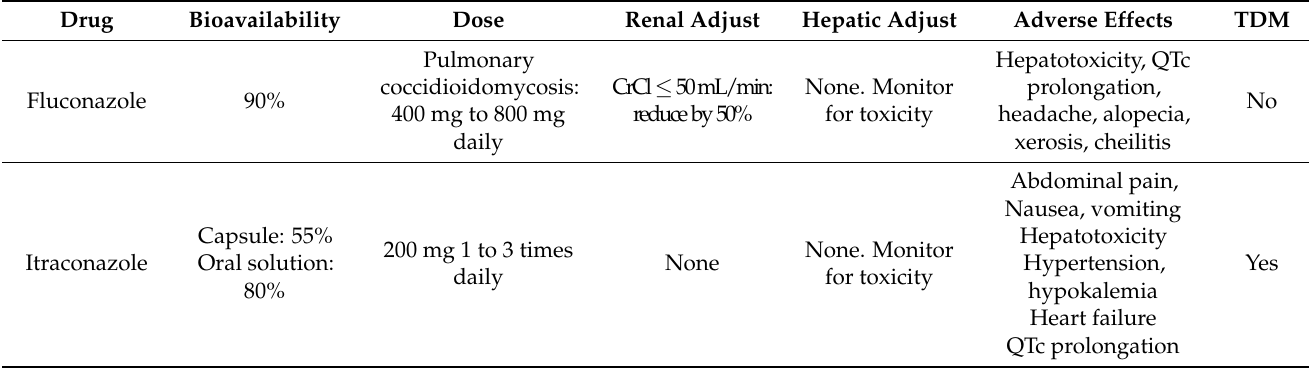
Table 1. Characteristics of systemic antifungal